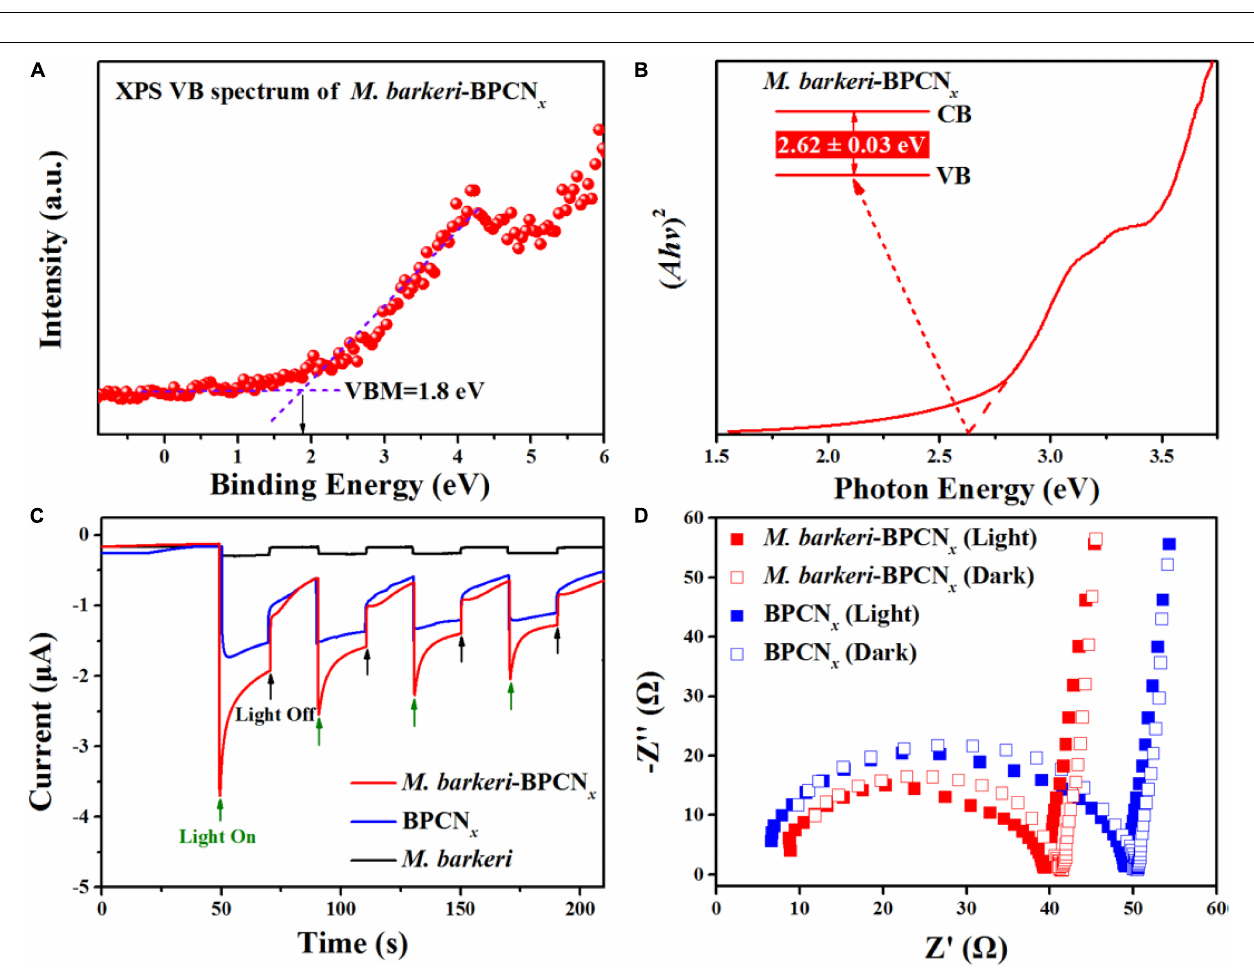
stability of M. barkeri -BPCN x . The estimated energy bands with the lowest unoccupied molecular orbital (LUMO) of -0.82 eV (vs. NHE) met the redox potential required for the reduction of CO 2 to CH 4 (Sun et al., 2018). To more intuitively characterize